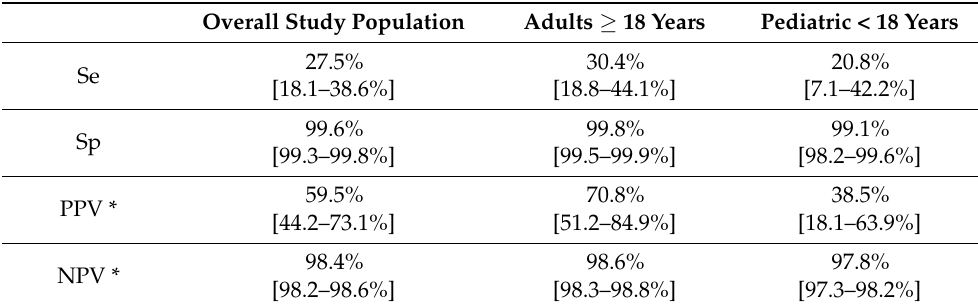
Table 3. Performance of the Rapid antigen test in